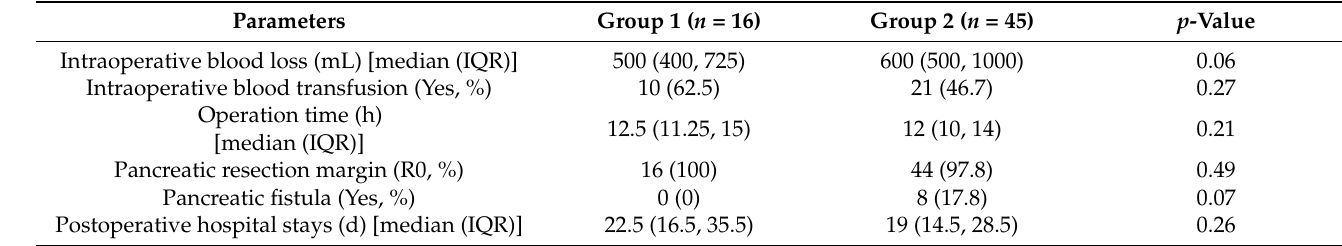
Table 2. Comparison of the general information between patients with PD of the two